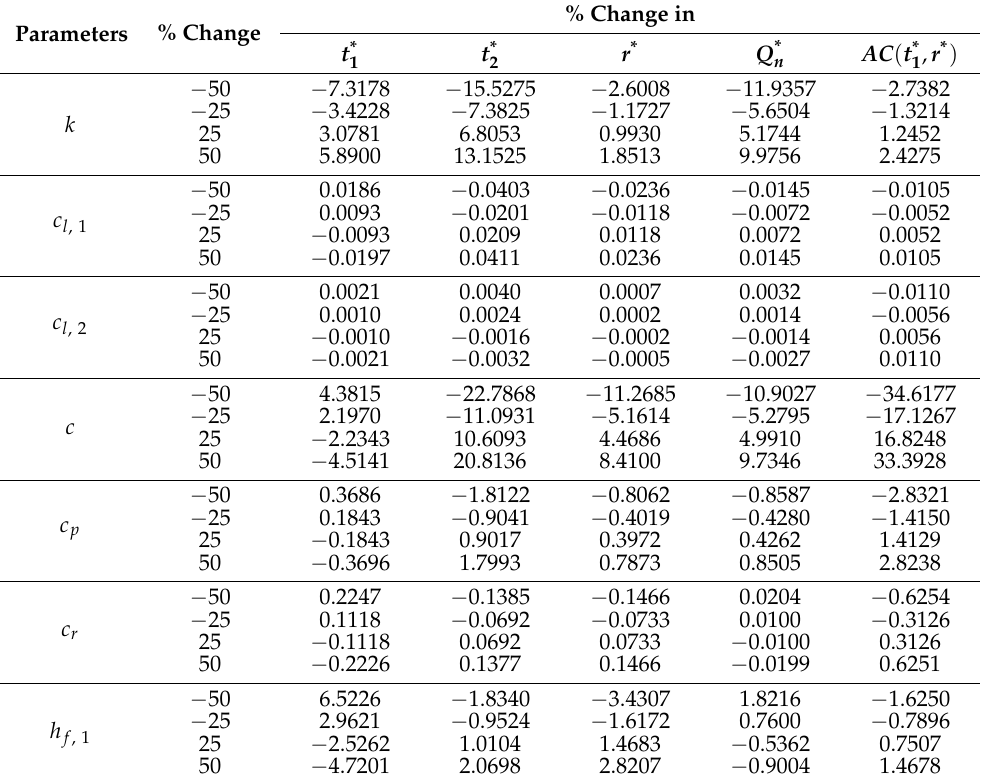
Table 3. Effect of changes in various parameters based on numerical